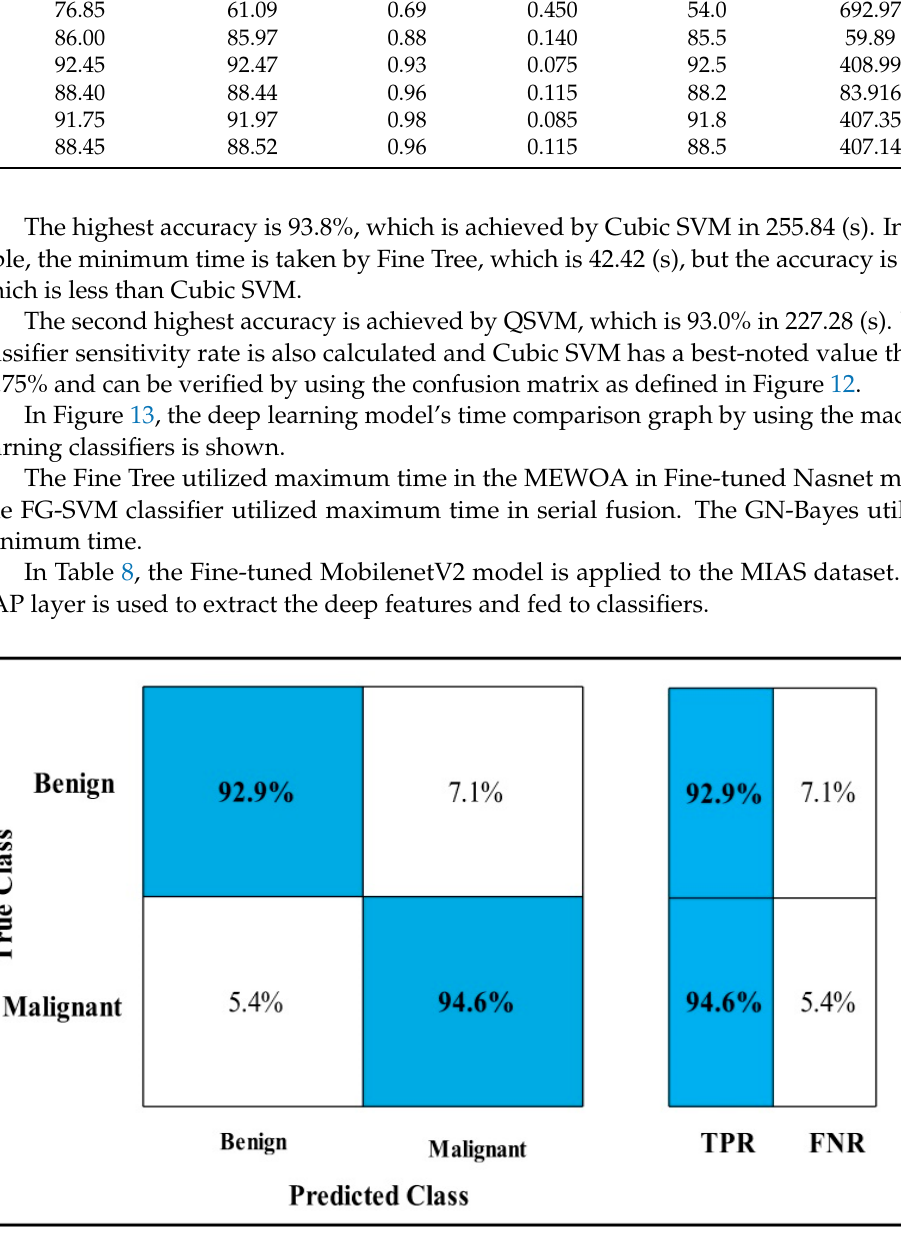
Figure 12. MEWOA on fusion TPR for CBIS-DDSM.